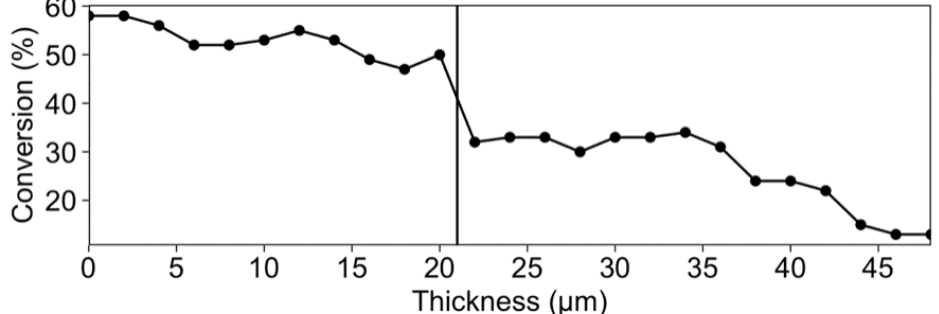
15 of 21 Figure 9. ( A ) Wrinkle amplitudes and ( B ) frequencies according to PBGMA concentration. Three samples per formulation were analyzed. The amplitude values are averaged from three measure- ments and the frequency values from an average of 100 random X profiles. No wrinkles were observed at 0, 1, and 2 wt.% PBGMA. However, with the addition of 3 wt.% PBGMA or more, wrinkles appeared. The amplitude increased up to 5 wt.% loading, and then decreased at higher PBGMA contents. This tendency was also verified by surface roughness measurements (Figure 8). According to Equation (8), it is possible to predict the critical wavelength (  cr ) of the wrinkle patterns as a function of skin mod- ulus (E f ), thickness (h f ), Poisson’s ratio (  f ), and compressive stress (  0 ) [29]. The mini- mum stress required for wrinkling is defined as the critical compressive stress, and the wavelength of the corresponding wrinkle pattern is defined as the critical wavelength [31]. In systems with a viscous sublayer, the viscosity or thickness of the viscous sublayer does not have any effect on  cr ; however, it does determine its growth rate [59 – 61]. In addition, the critical wavelength shows a stronger dependence on the skin thickness. To obtain a quantitative measure of the skin thickness (h f ), depthwise CRM meas- urements were performed after the first UV irradiation pass. This technique allowed us